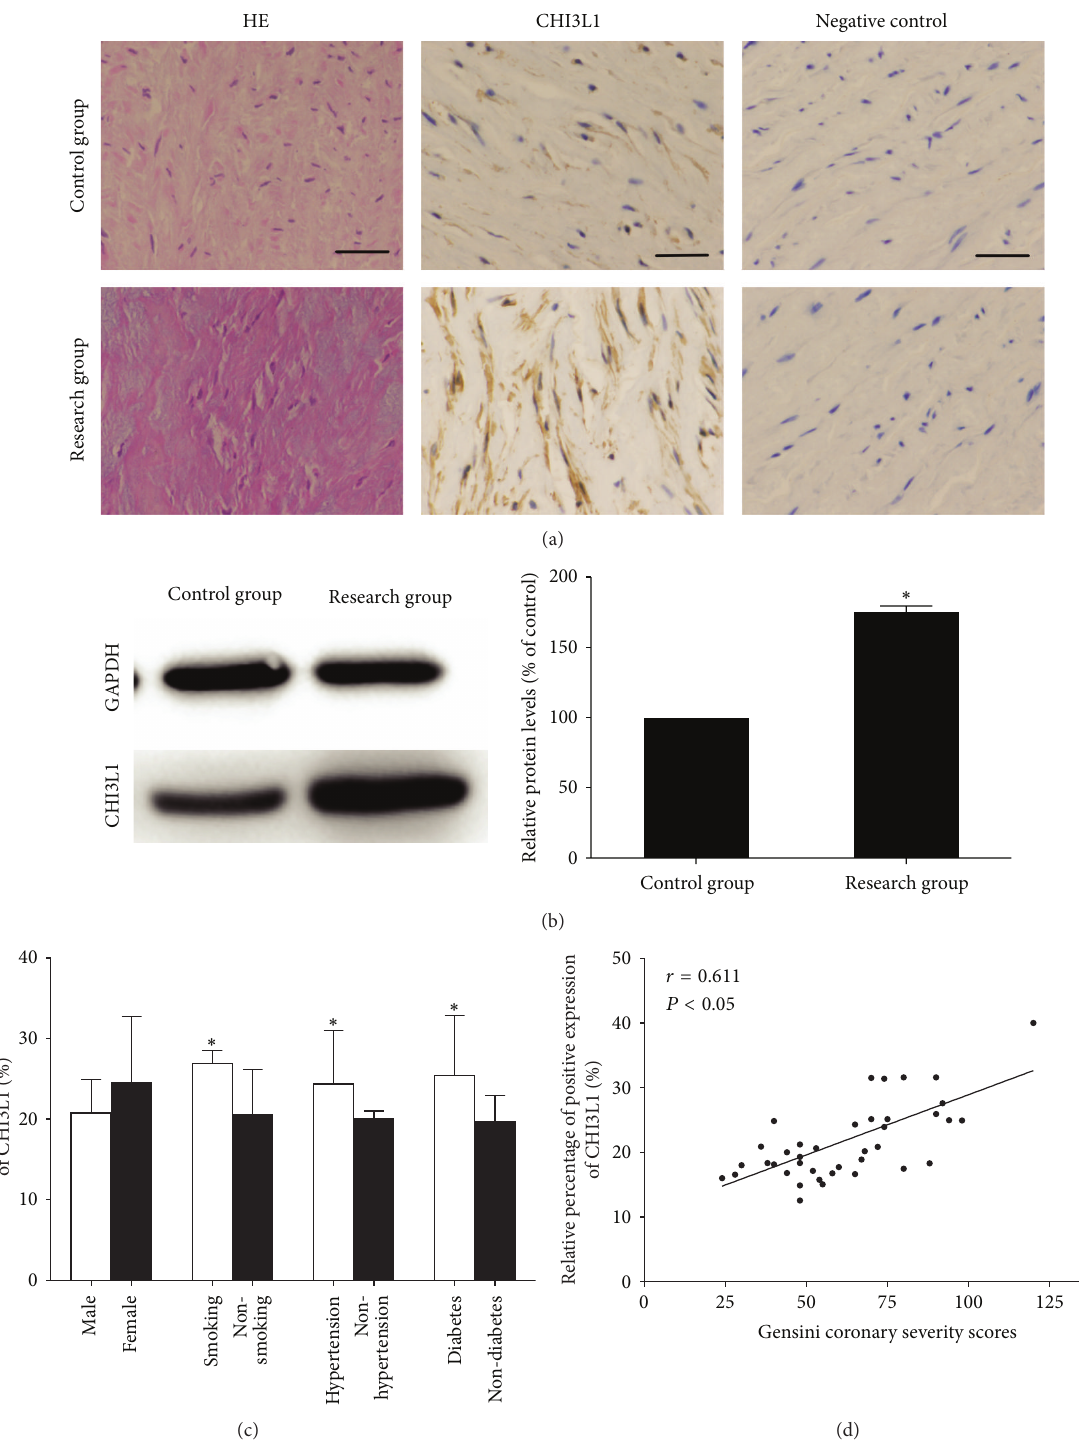
Figure 1: (a) Immunohistochemical staining of CHI3L1 on sections of arterial vessels in control group and research group. The expression of CHI3L1 was increased in the arterial specimens of CAD patients in research group. (scale bars = 100 𝜇 m) (b) Western blot analysis and quantification of CHI3L1 protein expression in control group and research group. The levels of CHI3L1 protein expression were higher in research group than in control group. ∗ 𝑃 < 0.05 versus control group. (c) Quantitative analysis of arterial CHI3L1 expression in research group patients according to gender, smoking, hypertension, and diabetes mellitus. The expression levels of CHI3L1 were elevated in smokers and patients with hypertension or diabetes mellitus, whereas gender had no significant effect. ∗ 𝑃 < 0.05 . (d) Relationship between arterial CHI3L1 expression and coronary severity scores. The arterial CHI3L1 expression levels were significantly correlated with coronary severity Gensini scores. Each point represents one